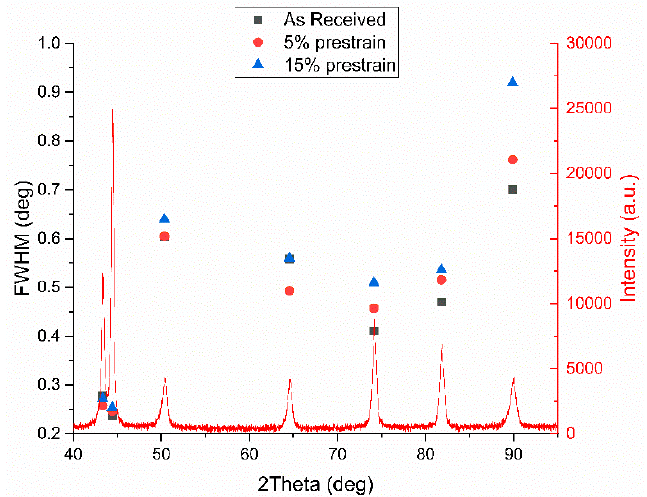
Figure 6. X-ray diffraction pattern together with full width half maximum values of the set of three samples.